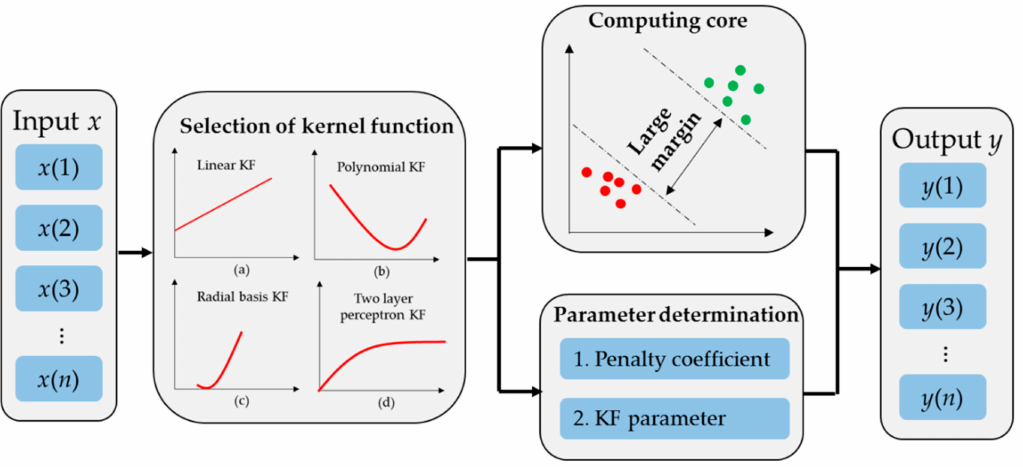
Figure 3. The model of the support-vector machine